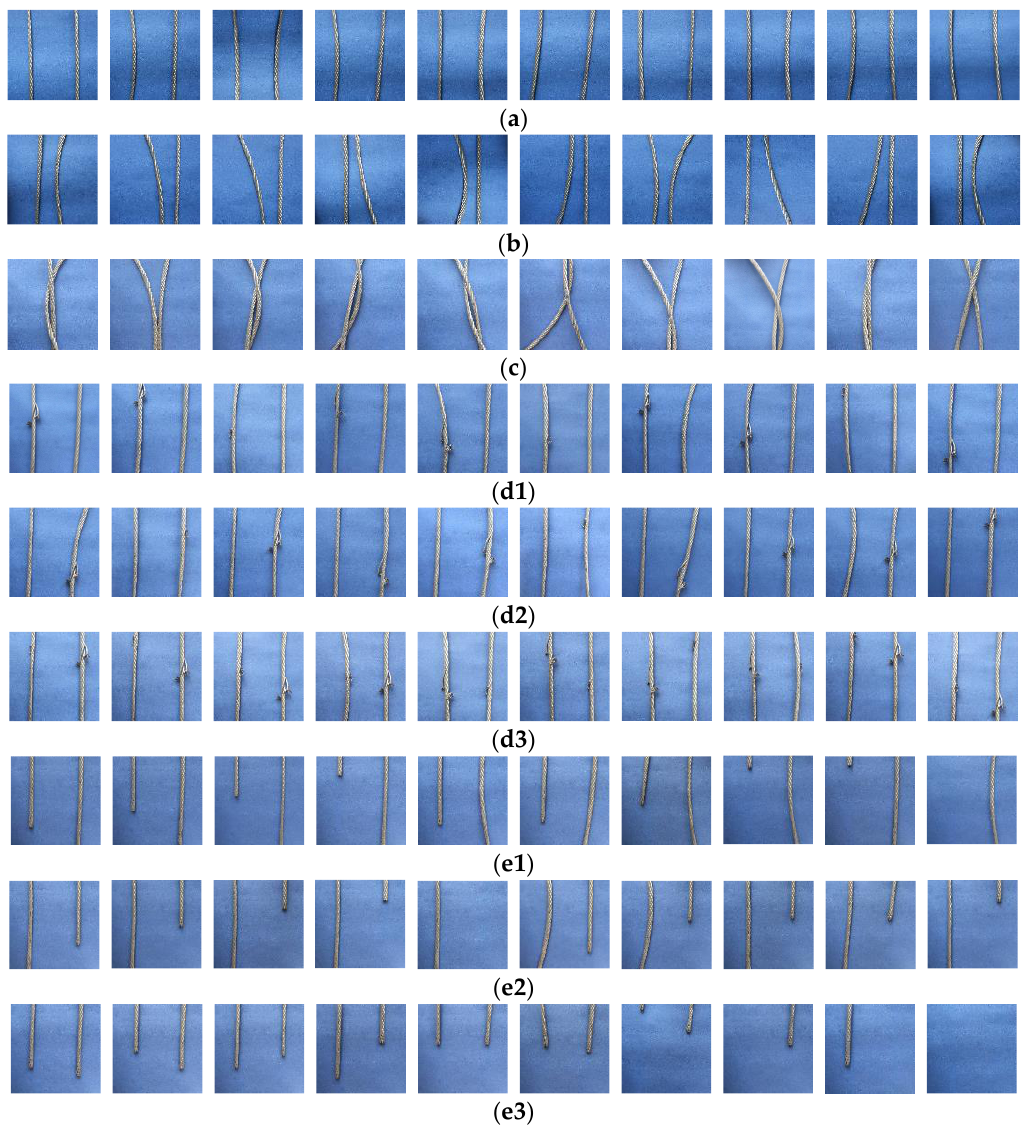
Figure 6. The seed images. ( a ) Normal; ( b ) disproportional spacing; (c) twisted rope; ( d1 ) broken strand of the left rope; ( d2 ) broken strand of the right rope; ( d3 ) broken strand of double rope; ( e1 ) left broken rope; ( e2 ) right broken rope; ( e3 ) double broken